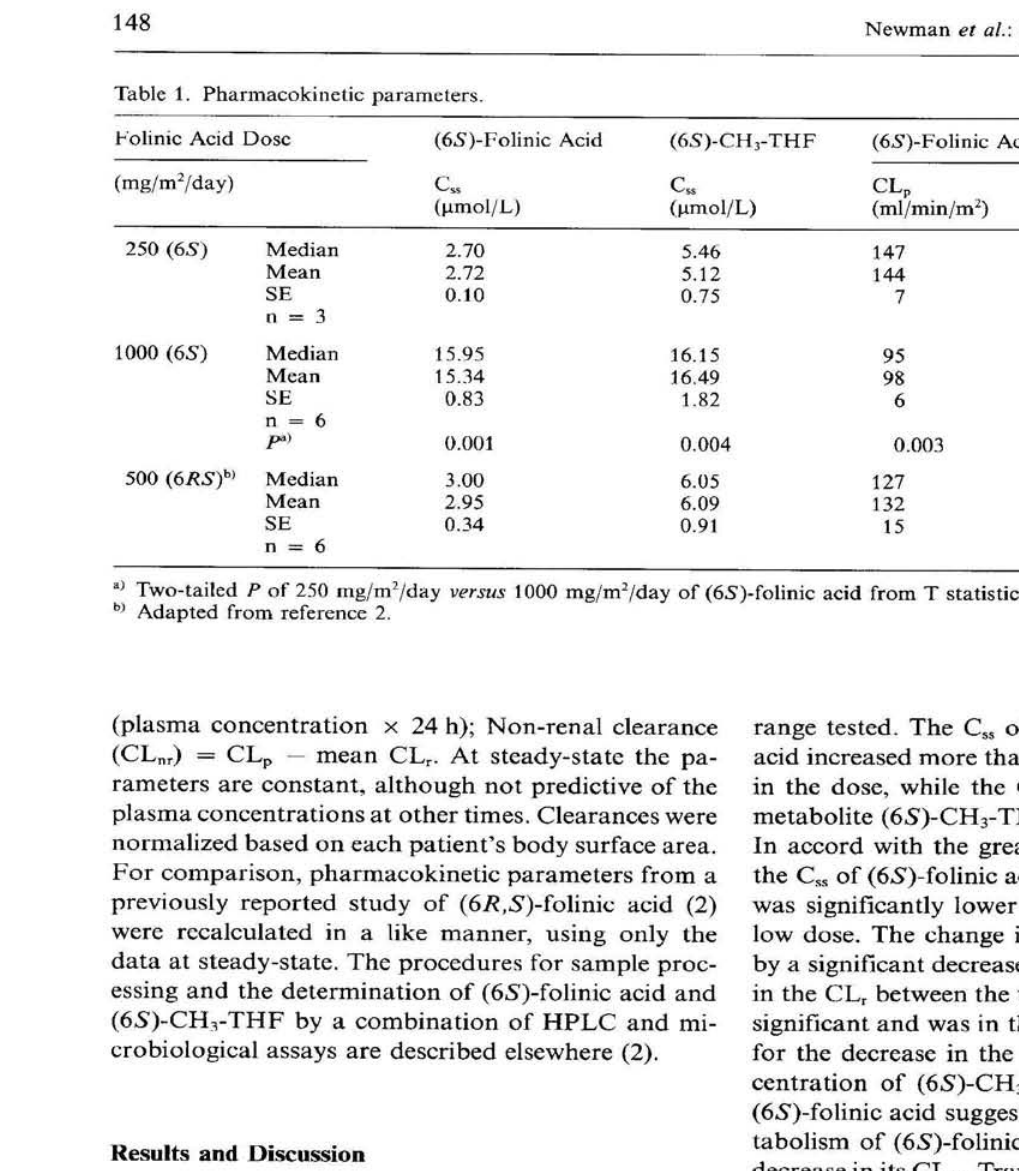
Table 1. Pharmacokinetic parameters. Eolinic Acid Dose (óSJ-Folinic